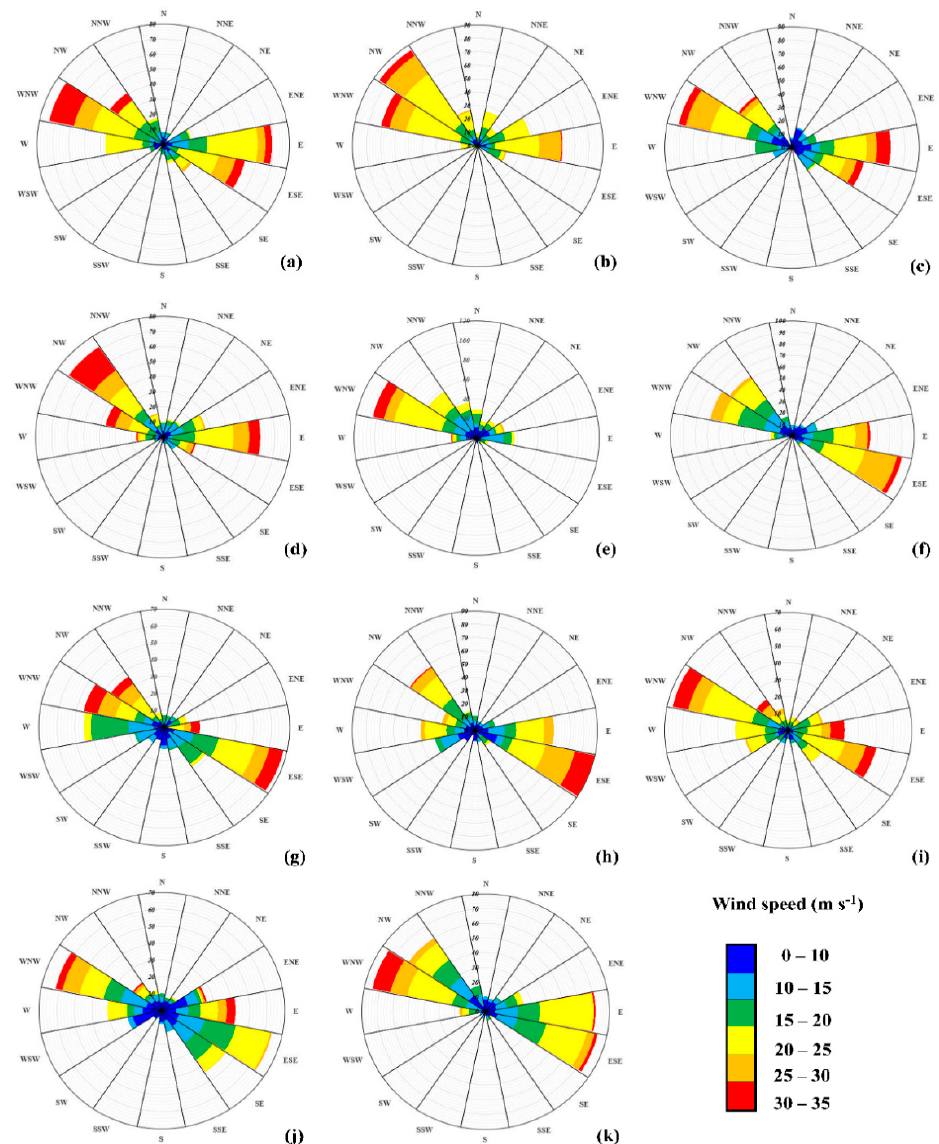
Figure 3. Wind frequency (in percentage, %) diagrams at ( a ) January, ( b ) February, ( c ) March, ( d ) April, ( e ) May, ( f ) June, ( g ) July, ( h ) August, ( i ) September, ( j ) October, and ( k ) November 2016.